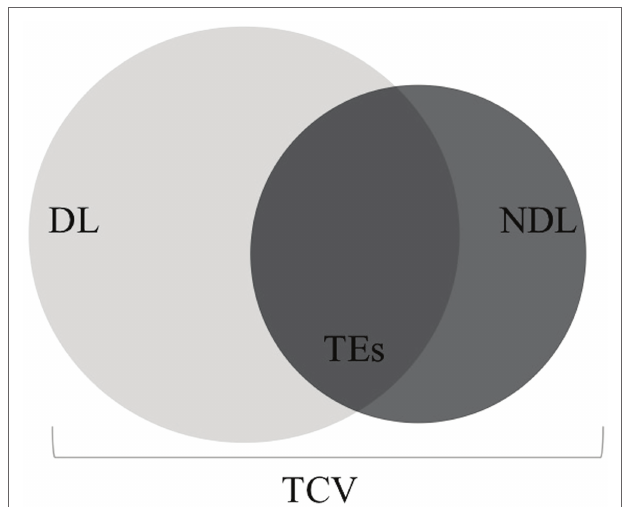
FIGURE 1 | Model of overlap between lexical-semantic space across the dominant and non-dominant language underlying priming effects. DL = Dominant Language vocabulary, NDL = Non-Dominant Language vocabulary, TEs = Translation Equivalents, and TCV = Total Conceptual